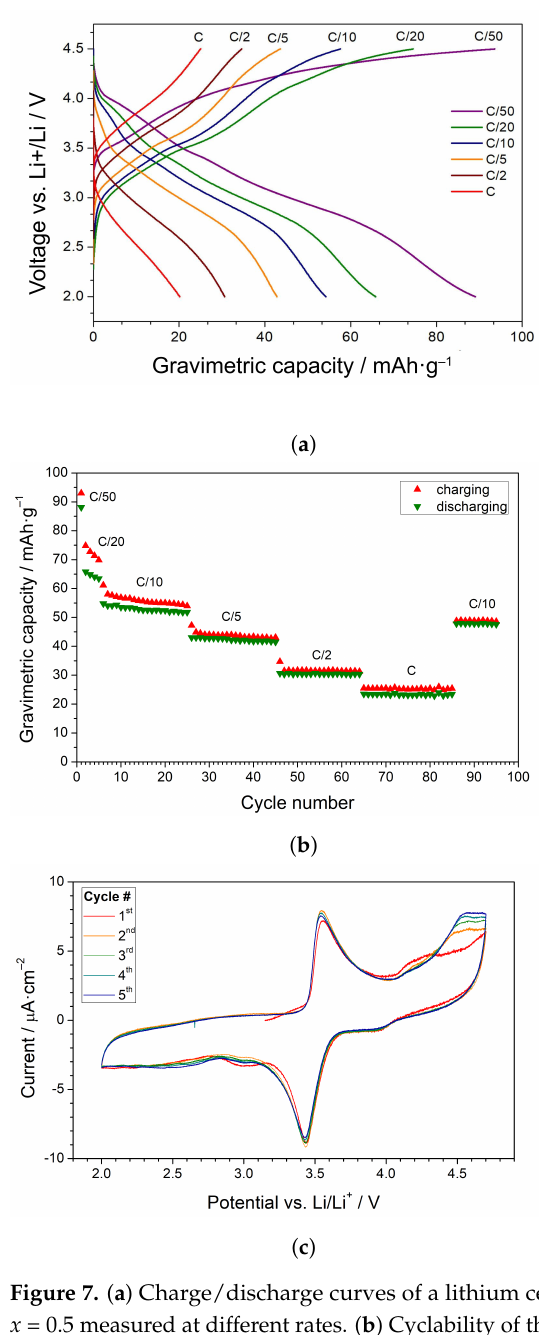
Figure 7. ( a ) Charge/discharge curves of a lithium cell made of the nanocrystallized sample with x = 0.5 measured at different rates. ( b ) Cyclability of the cell. ( c ) Cyclic voltammogram of the cell for 5 cycles measured at the scanning rate of 0.05